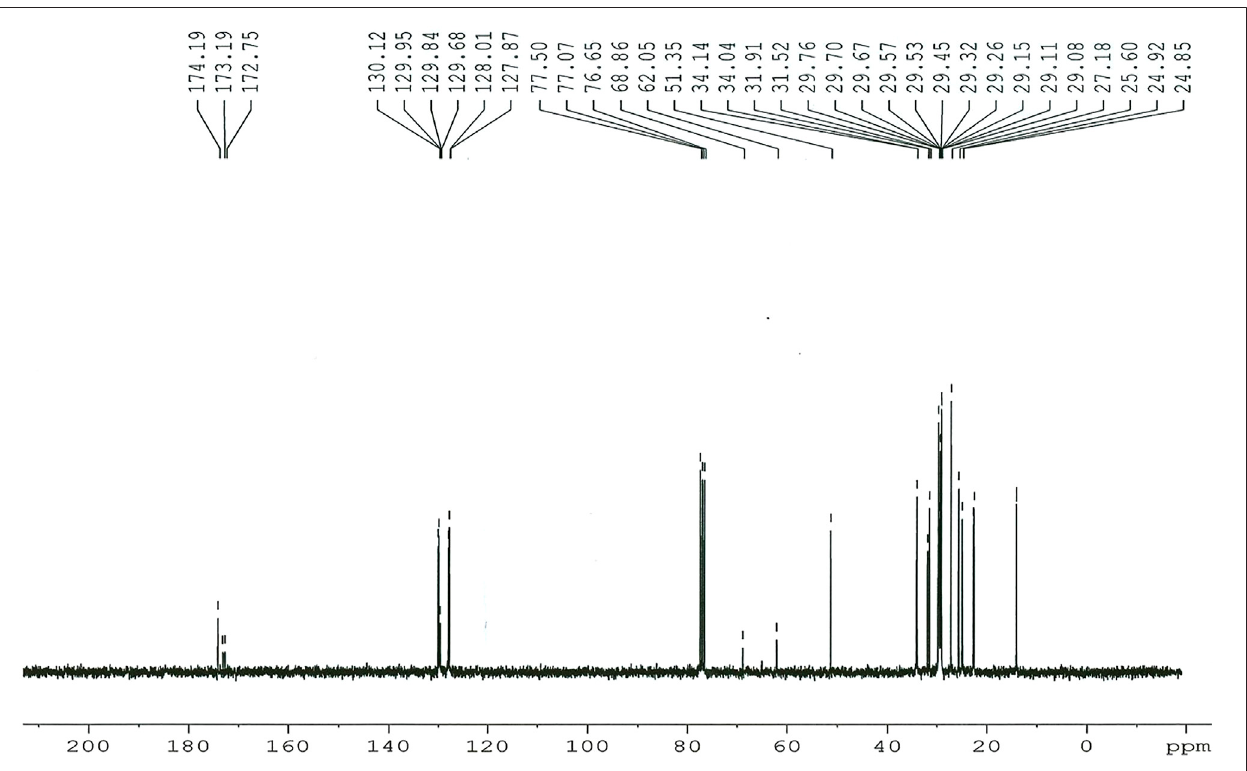
FIGURE 10 | 13 C NMR spectrum of the Dodonaea